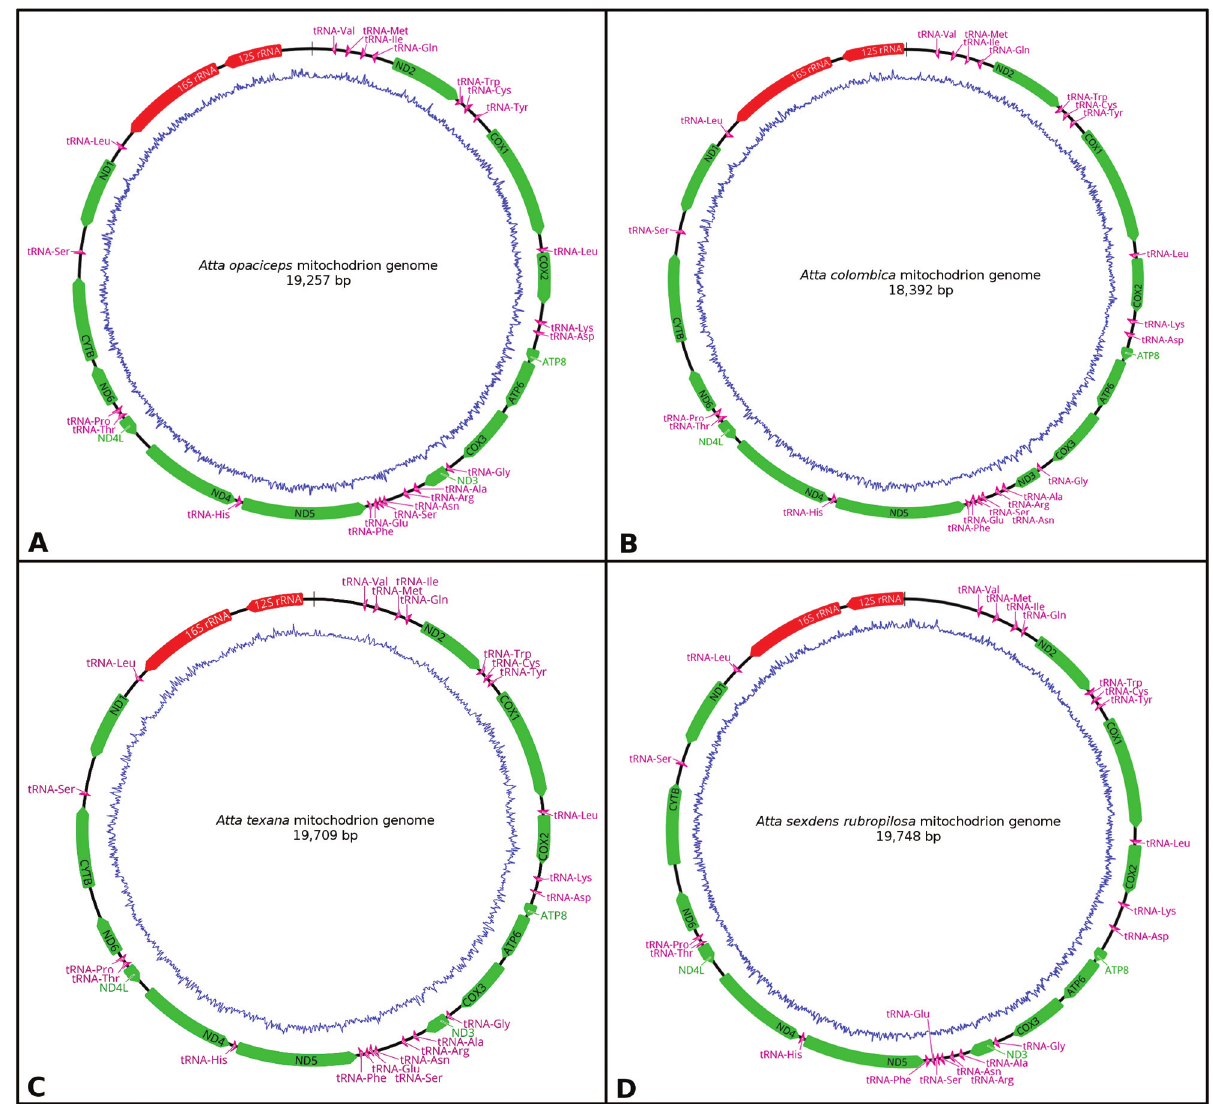
Figure1 -Completegenemapof Attaopaciceps (A), Attacolombica (B), A.texana (C),and Attasexdensrubropilosa (D)mitogenomes.Genesinthecir- cleandoutsidethecirclearetranscribedinclockwiseandcounterclockwisedirections,respectively.Theprotein-codinggenesareshowningreen,rRNAs in red, and tRNAs in purple. The green ring represents the A+T contents and the blue ring shows C+G